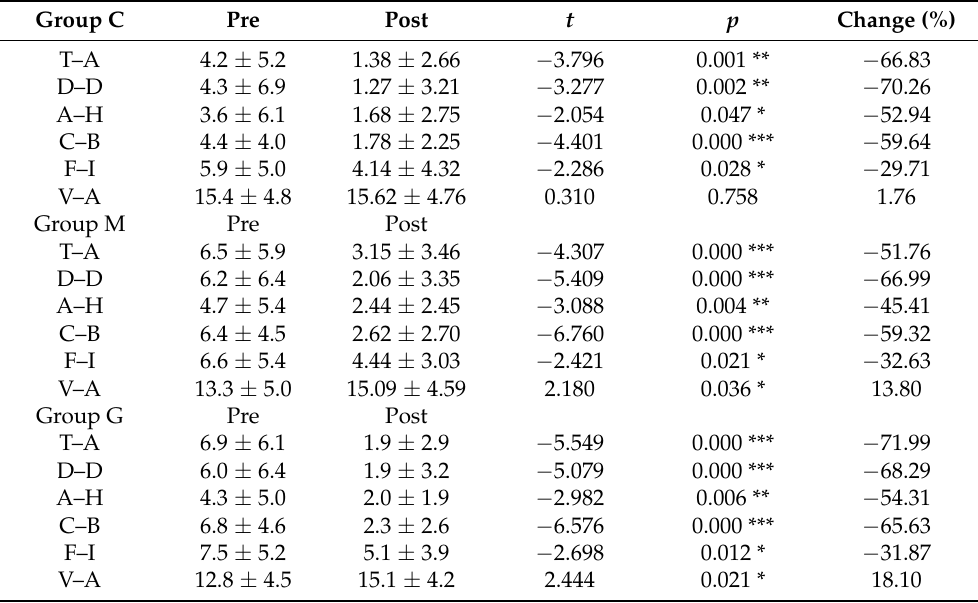
Table 7. Paired-sample t-test results of psychological responses in the three programs. Group C